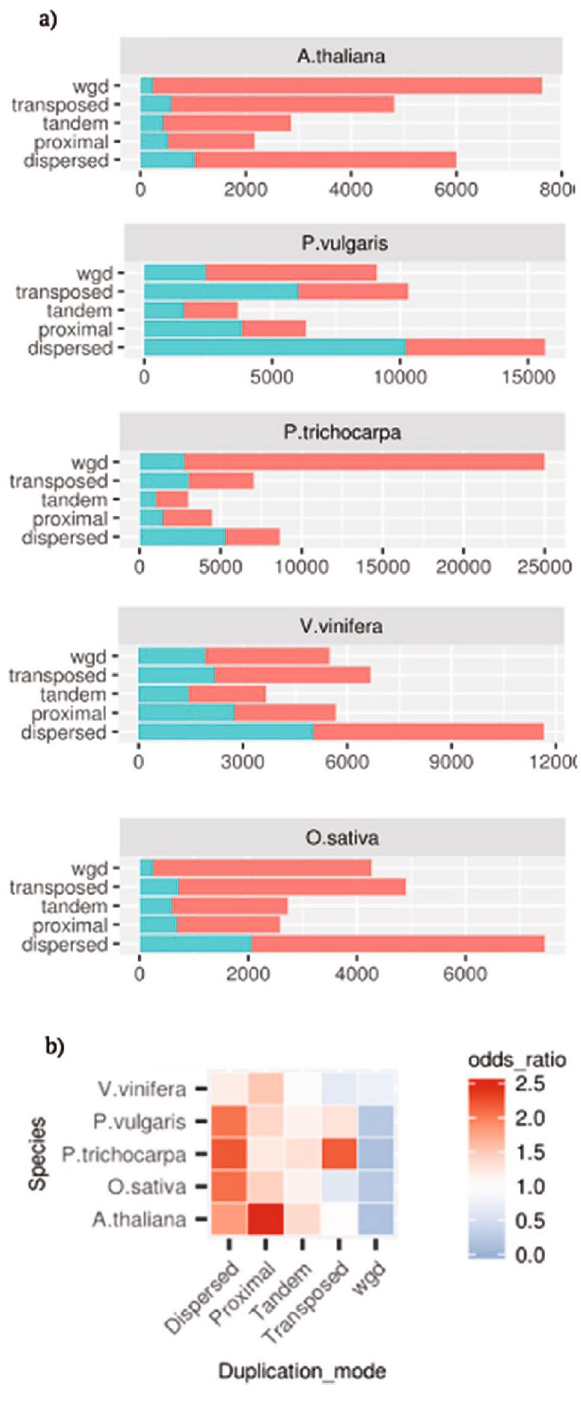
Figure 4. Pseudogenes (blue) and functional loci (red) classifications across the five investigated species based on analysis of the maps of collinearity. ( b ) Odds ratios for the proportions of pseudogenes versus functional loci based on the defined mode of duplication. Significance of odds ratio>1.0 or<1.0 tested by Fisher’s exact tests; white squares, P